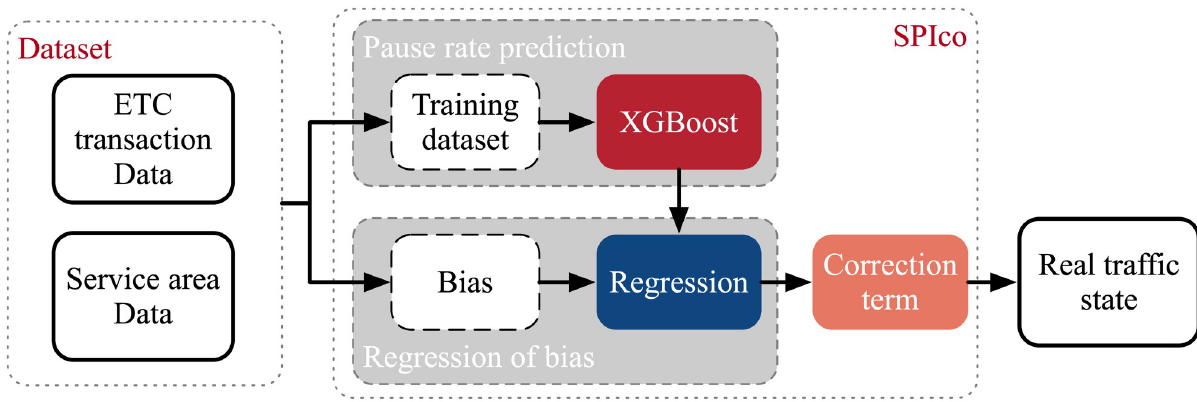
Fig 2. Proposed research